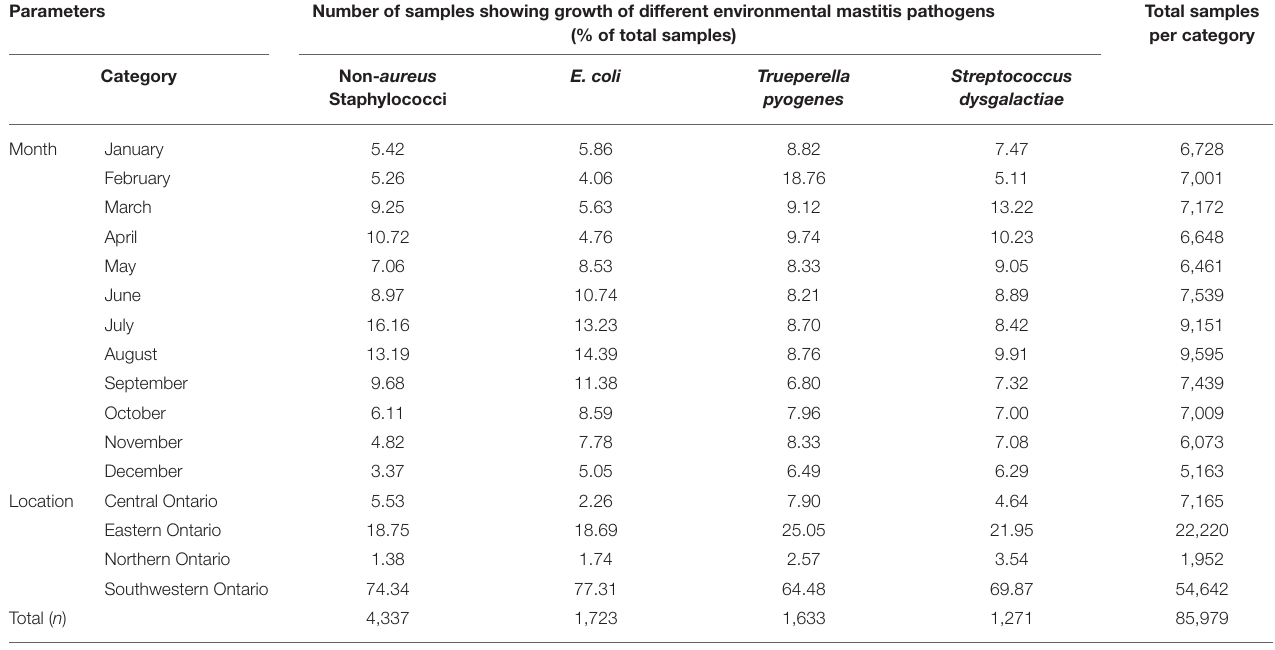
TABLE 4 | Temporal (monthly) and spatial change in the proportion of bovine milk samples positive for various environmental mastitis pathogens between 2008 and 2017 in Ontario, Canada. Parameters Number of samples showing growth of different environmental mastitis pathogens